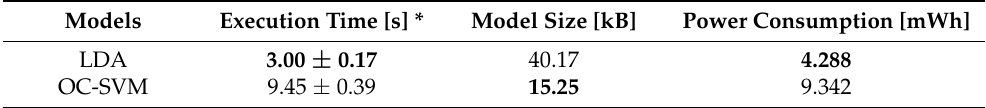
Table 4. The experimental results on Raspberry Pi.